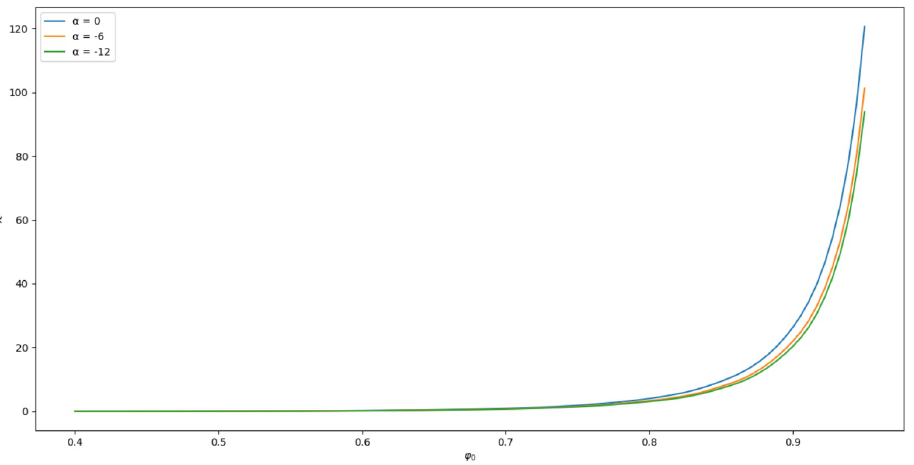
Figure 6 . The dimensionless curvature R as a function of ϕ 0 for fixed values of α , for Nut end- point solutions.